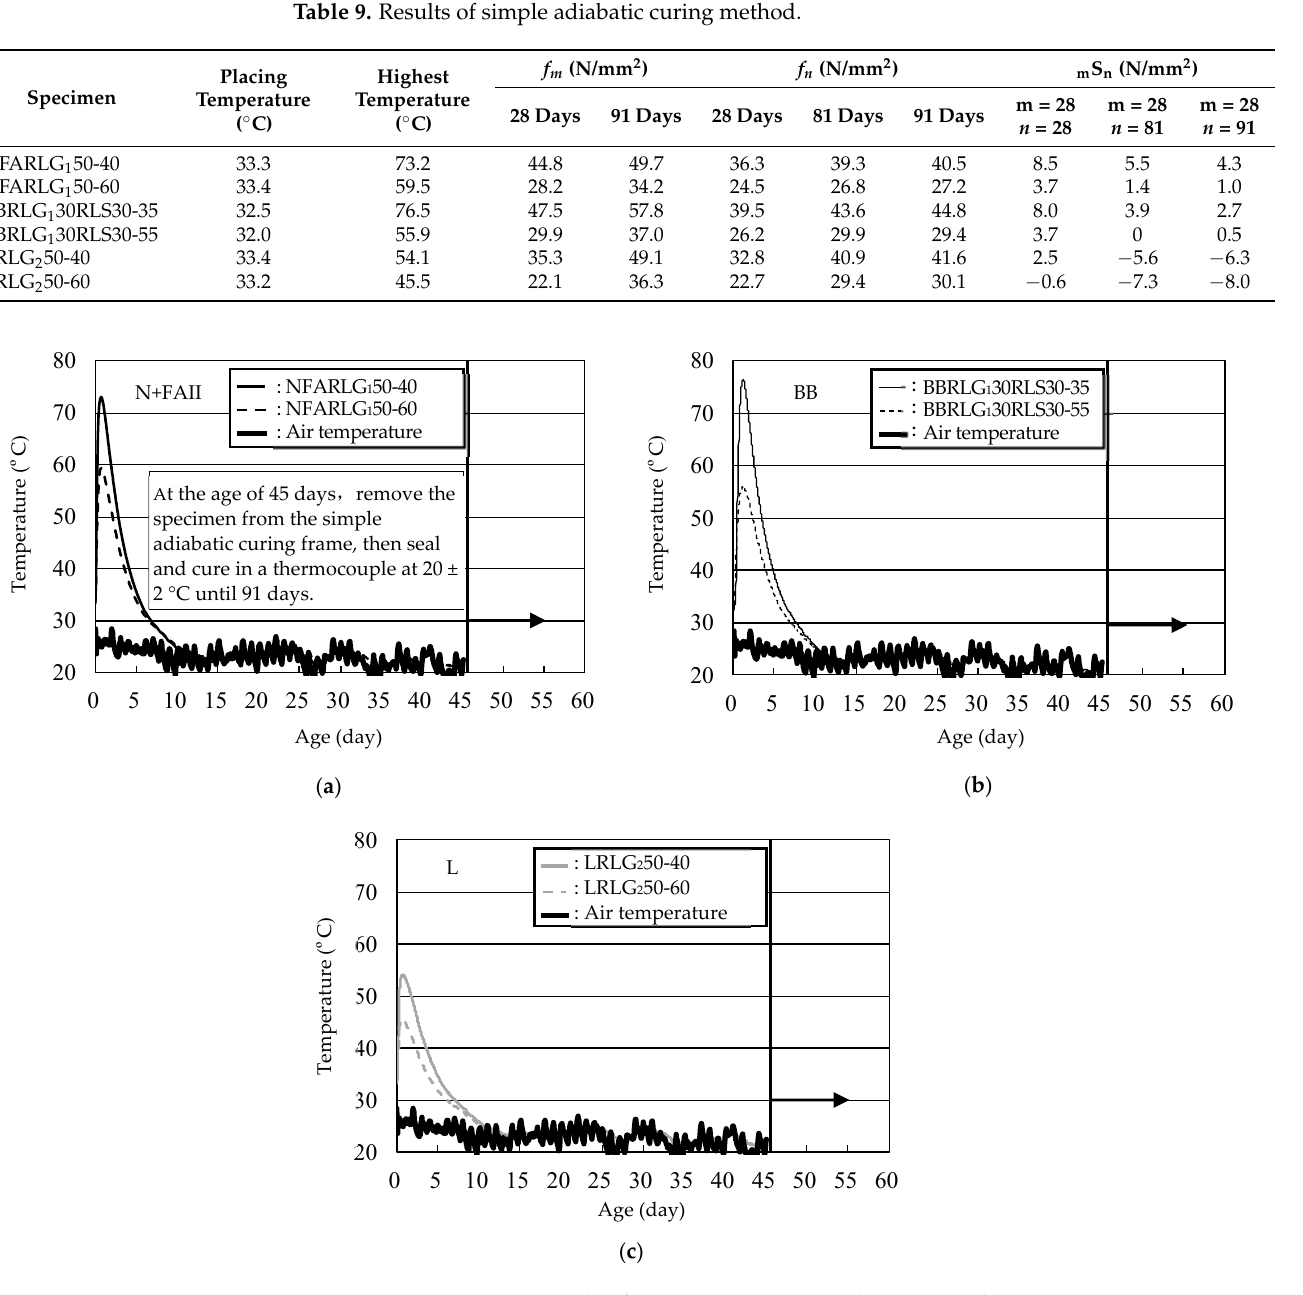
Figure 3. Temperature records of simple adiabatic cured specimens by cement type: ( a ) N + FAII, ( b ) BB, and ( c ) L.